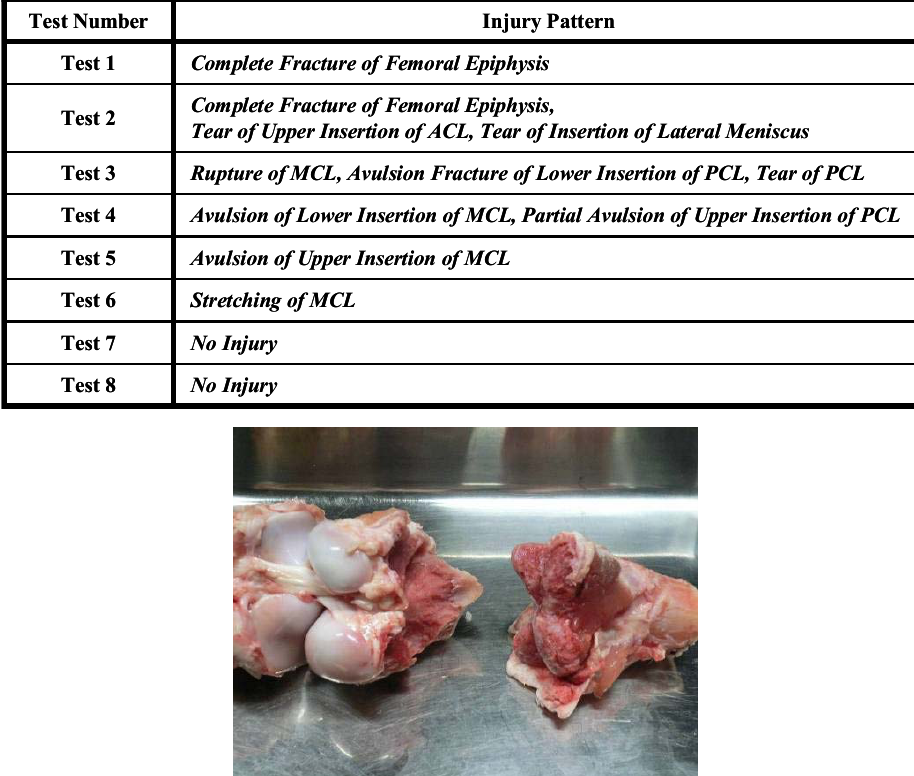
Fig. 4 Injury pattern of knee joint for drop height of 700 mm (test 1). Femoral epiphysis is fractured and the continuity of the epiphysis was completely destroyed.